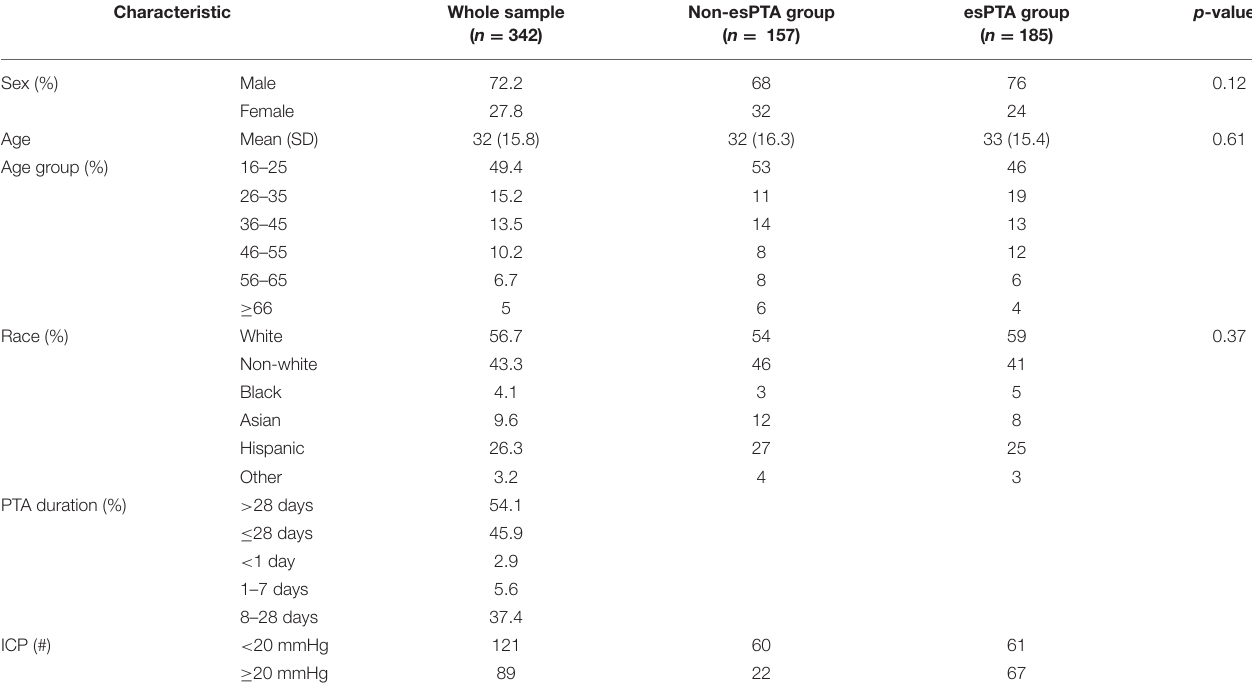
group x time interaction were corrected using the Greenhouse- Geisser correction to account for the sphericity violation. Post hoc pairwise comparisons were used to further investigate the group x time interaction. Tests of between-subjects effects revealed a significant higher FIM total score (greater independence) in the non-esPTA group compared to the esPTA group across all time points ( p < 0.001; Figure 3 and Table 2 ). Within group comparisons across time revealed significant improvements in FIM total score in the non- esPTA group from admission to discharge and discharge to 1 year follow-up ( p < 0.001) and no significant differences were observed from year 1 to year 2 ( p = 0.078) and from year 2 to year 5 follow-up ( p = 0.274) ( Figure 3 and Table 2 ). The esPTA group showed significant improvements in FIM total score from admission to discharge, discharge to year 1, and year 1 to year 2 ( p < 0.001); year 2 to year 5 did not show significant improvements ( p = 0.667) ( Figure 3 and Table 2 ).